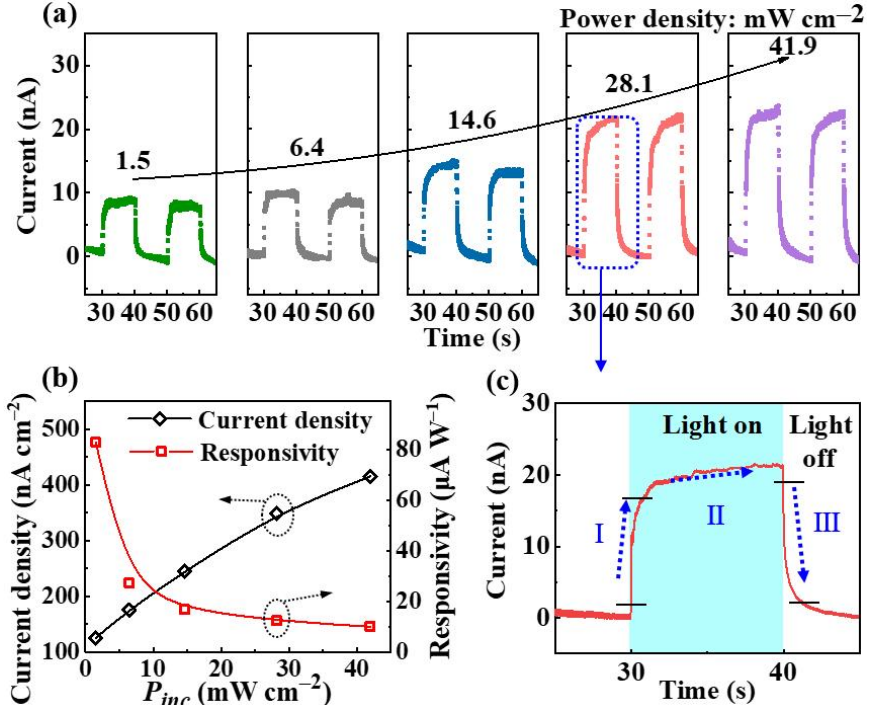
Figure 3. ( a ) Photo-switching behaviors of the self-powered PEC PD under 365 nm illumination with different incident light–power densities (Unit: mW cm -2 ). Different colors indicate different incident light–power densities. ( b ) Photocurrent density and responsivity as a function of the incident light–power density. ( c ) Response of PEC PD under 365 nm illumination at a zero-voltage bias. Table 1. Comparison between this work and other recently reported PDs.